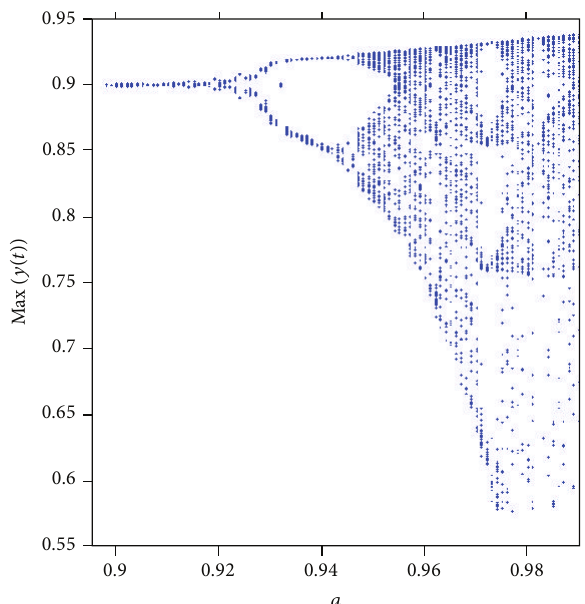
Figure 7: Bifurcation diagram for system (1). From left to right we see bifurcations of period- 2 𝑘 : as the value of the parameter 𝑎 increases, successive bifurcations occur, resulting in chaos.